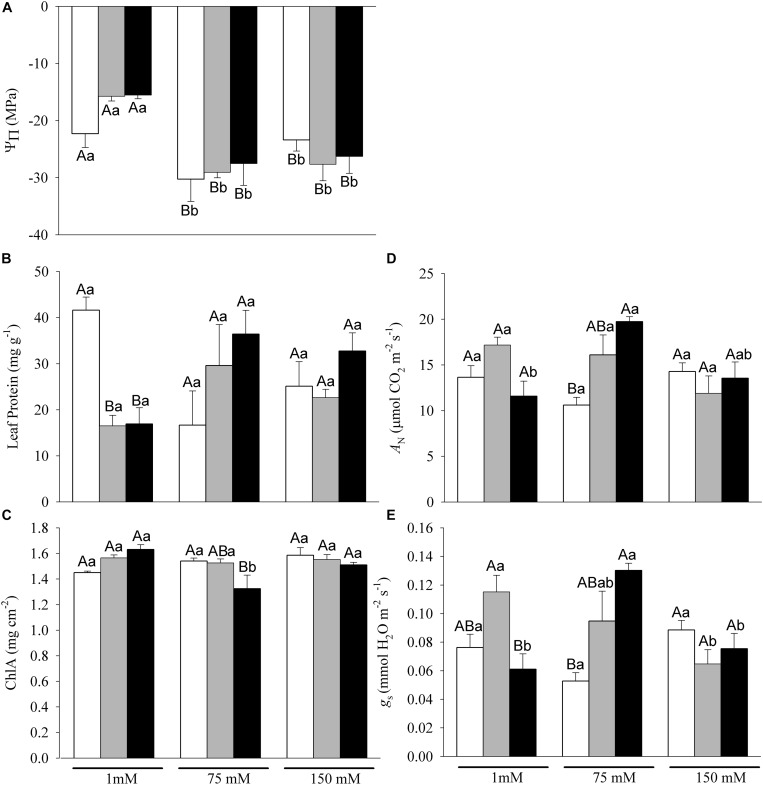
Leaf physiological traits: (A) Osmotic potential (Ψπ), (B) Leaf protein, (C) Chlorophyll a concentration (Chl a), (D) Net Photosynthesis rate (AN), (E) Stomatal conductace (gs) of C, P and AM plants (white, gray and black bars, respectively) at 1, 75 and 150 mM NaCl. Values are mean and SE of six replicates. Different capital letters indicate significant differences among nutritional levels (C, P and AM) within the same salt level, and lowercase letters indicate significant differences among salt levels within the same nutritional level, from post hoc Tukey test.